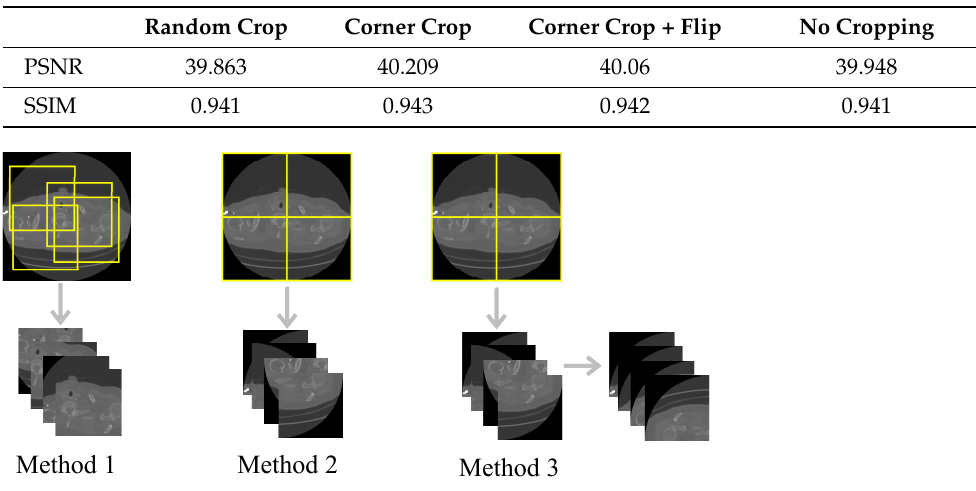
Table 5. Restoration results of different patch interception methods.